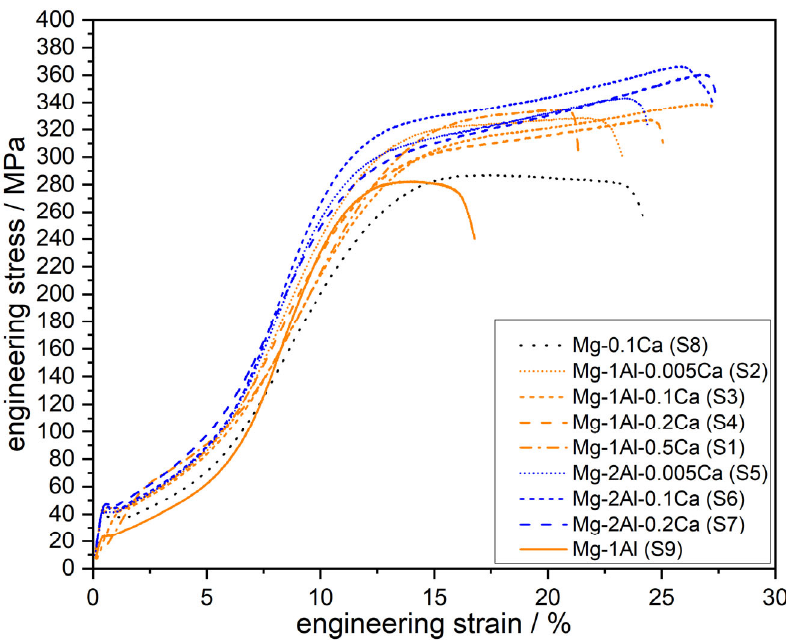
Figure 1. Stress–strain behaviour of the investigated Mg-Al-Ca alloys under compression loading in TD direction.